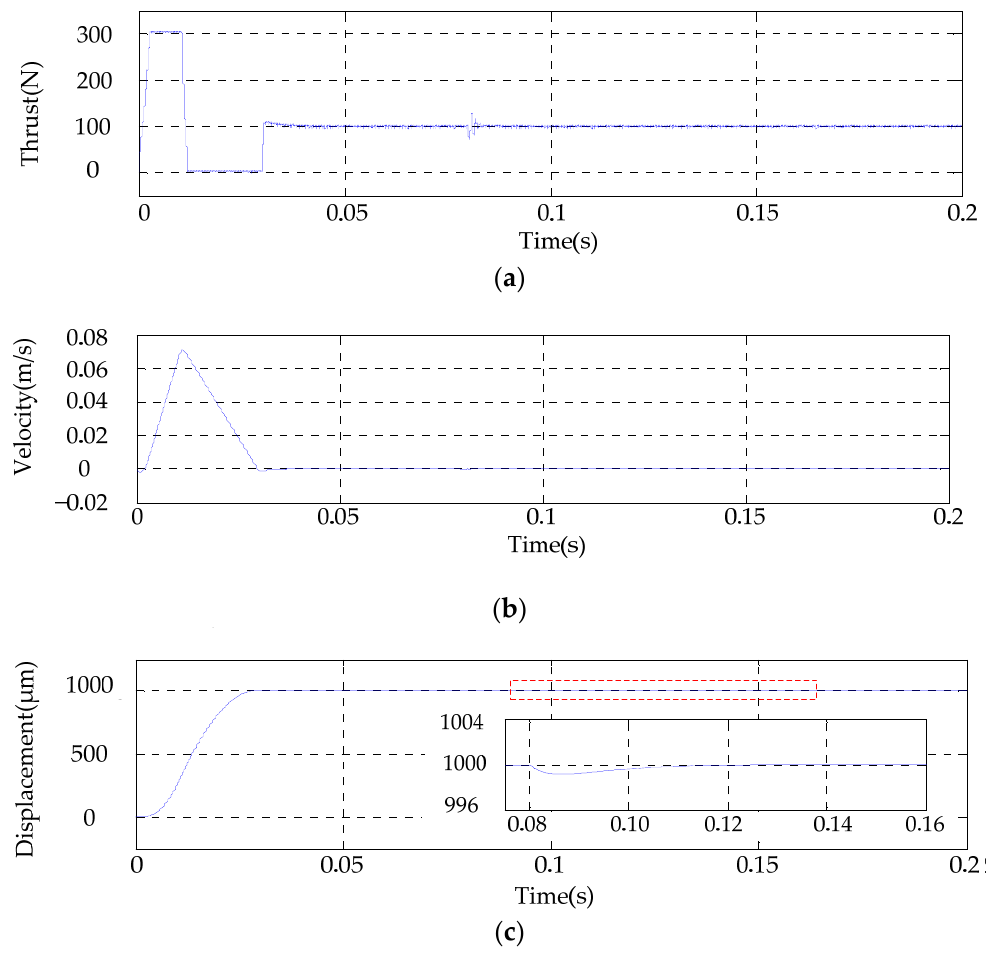
Figure 7. Y 2 Linear Motor: ( a )Electromagnetic force; ( b ) Velocity; ( c ) Displacement in Y direction.